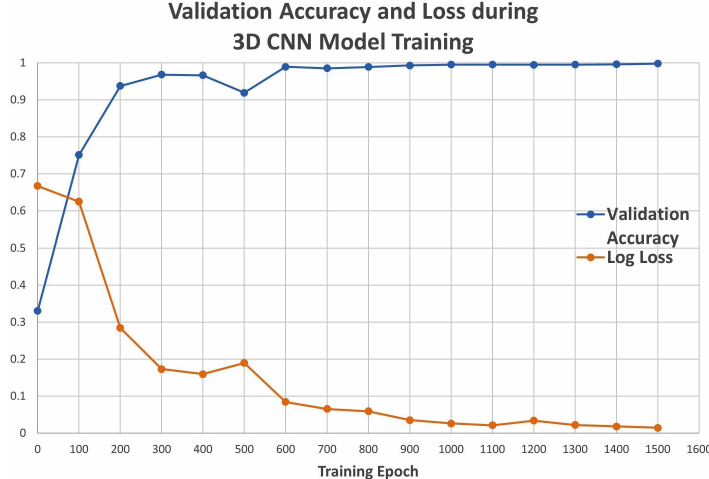
Figure 2. Dense artificial neural network (DNN) validation accuracy and loss.